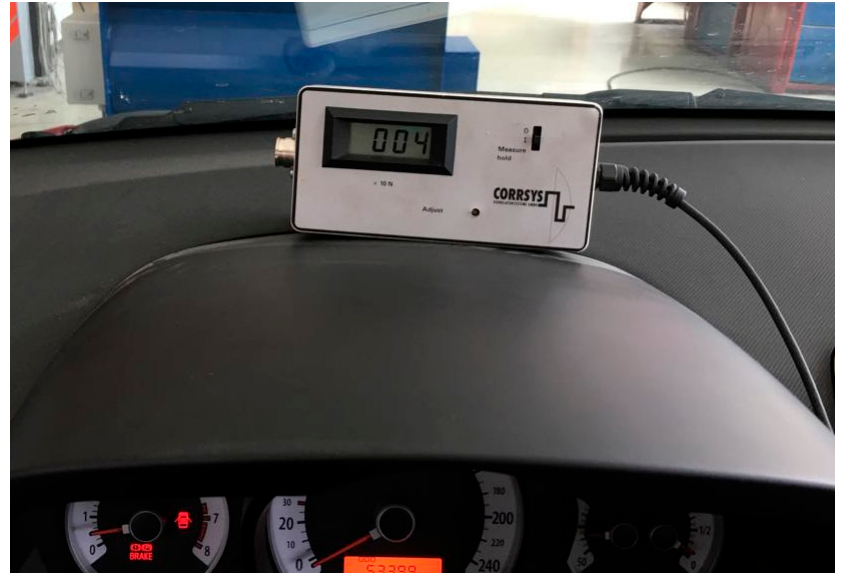
Figure 4. Pedometer used for measuring the effort to control the steering affecting the brake pedal.